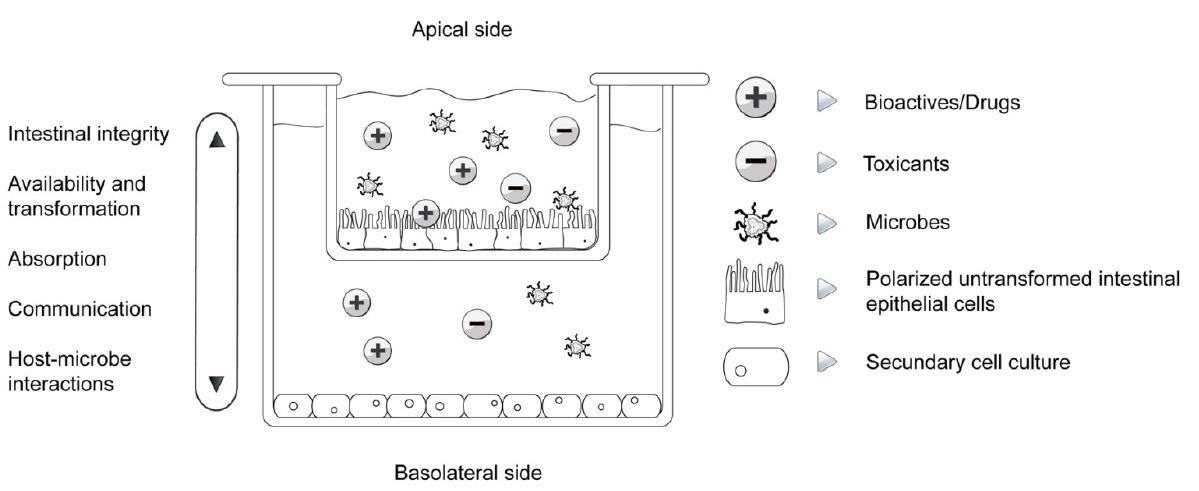
Figure 3. 3D functional cell model of the